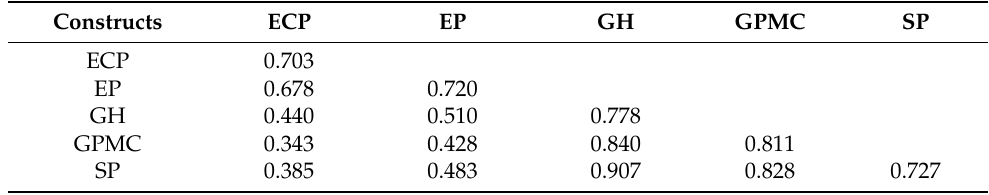
Table 4. Fornell–Larker criterion.